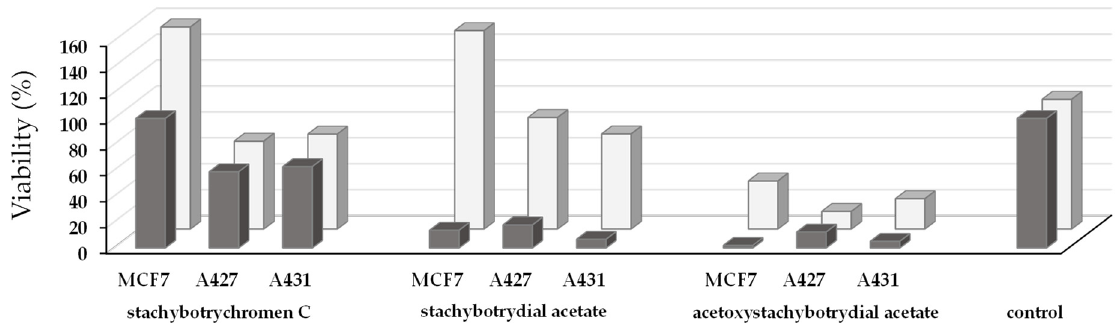
Figure 9. Cell viability of MCF7, A427 and A431 cells after 48 h treatment with stachybotrychromene C, stachybotrydial acetate and acetoxystachybotrydial acetate as tested by MTT assay at a concentration of 100 µ M (dark gray) and at a concentration of 1 µ M (light gray) in three independent experiments.